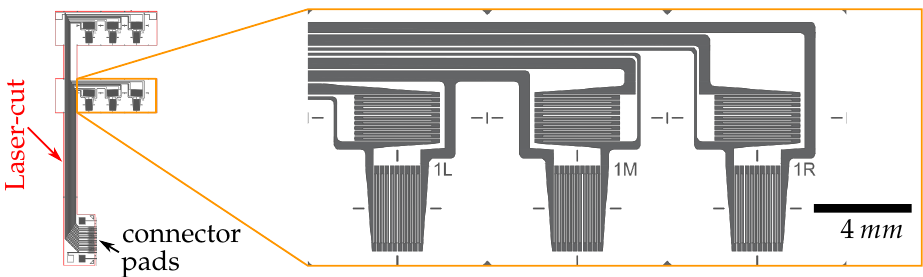
Figure 2. Smart inlay layout: The right part shows an enlargement of the first sensor row with the three sensor elements (1L: left, 1M: middle, 1R: right). Each sensor element consists of two sensor grids, one longitudinal and one with transverse orientation. The outer F-shape geometry of the inlay is created through laser cutting.